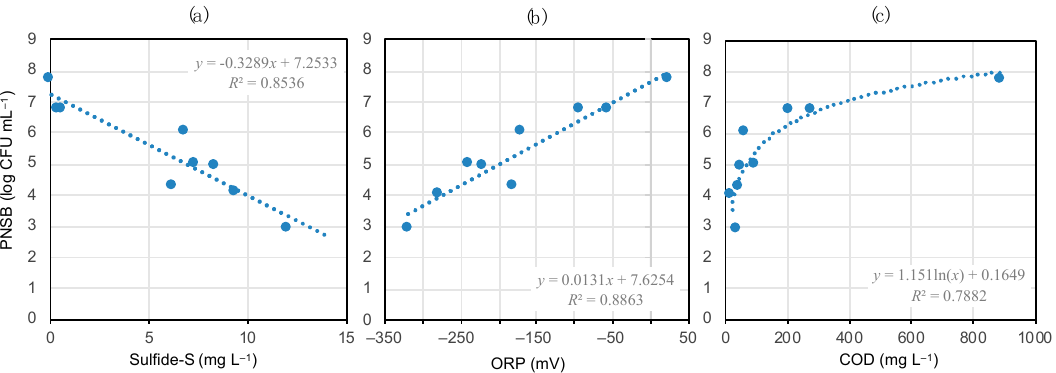
Figure 4. Correlations between the viable PNSB count and sulfide concentration ( a ), ORP ( b ), or COD ( c ) in the colored mat- and bloom-developing environments. The shaded areas show data on coastal samples. Deduced regression equations and correlation coefficients are given in the plots. The correlations in ( a – c ) are significant at p < 0.001, 0.001, and 0.005, respectively.